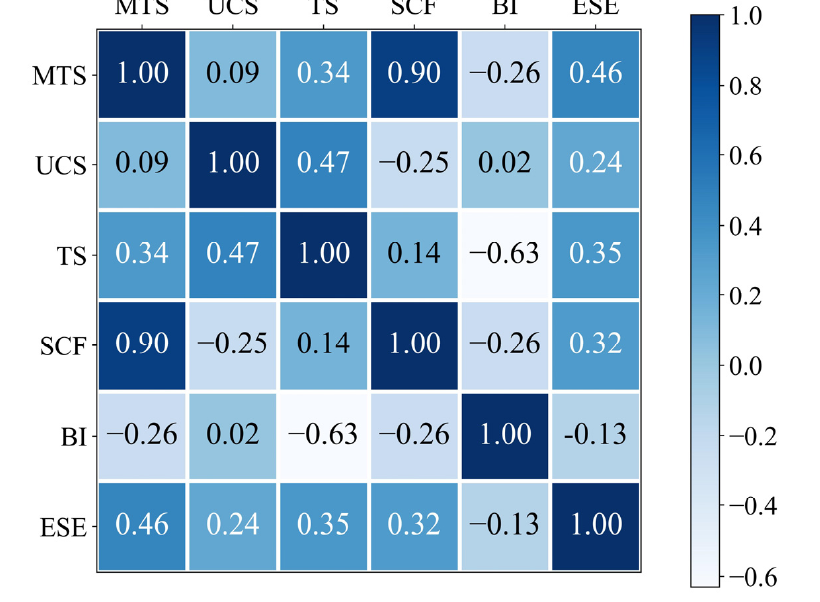
Figure 6. The correlation of six variables.